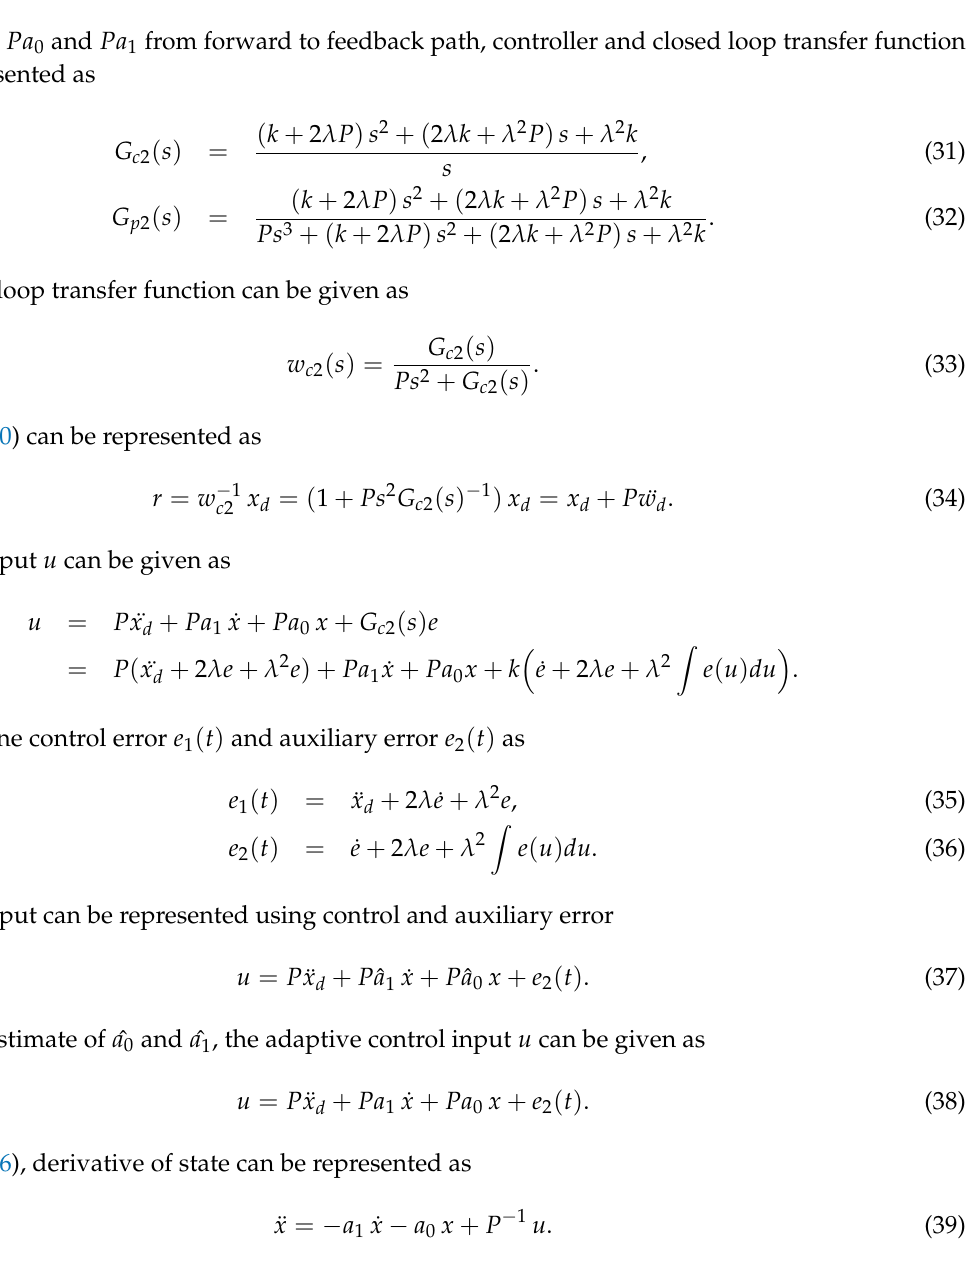
Figure 6. Modified block diagram of closed loop